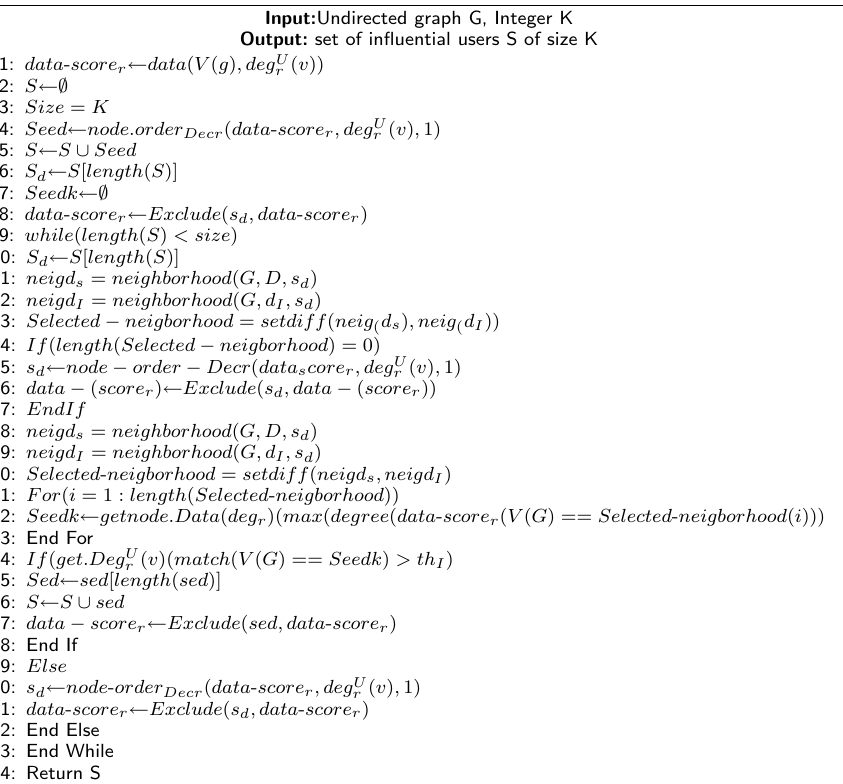
Algorithm 2 Top-K influential users selection UERND D-hops